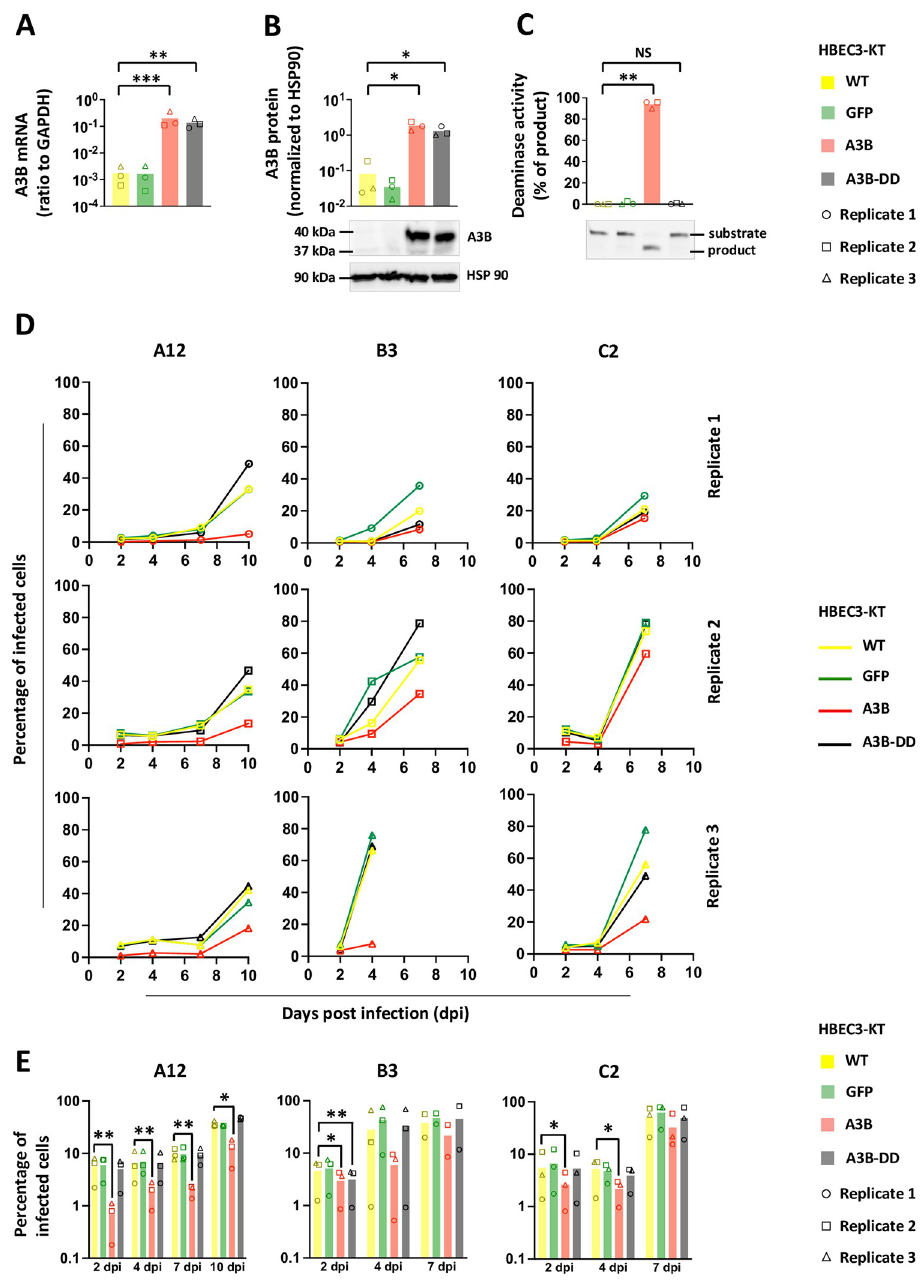
Fig 1. A3B slows down adenovirus propagation by a deaminase-dependent mechanism. Immortalized human bronchial epithelial cells HBEC3-KT were transduced to stably express the GFP, the APOBEC3B protein (A3B) or a catalytically inactive version of the APOBEC3B protein (A3B-DD for Deaminase Dead). (A) A3B mRNA levels were quantified by RTqPCR and expressed relative to GAPDH mRNA level. (B) A3B protein levels were assessed by western blot, quantified by densitometry and normalized with HSP90. (C) Total proteins were extracted in a non-denaturing buffer and mixed with the substrate of the deamination assay. Deaminase activity, if present in the cell lysate, will allow the conversion of substrates into shorter products. Substrates and products were quantified by densitometry. Deamination activities of the cell lysates were expressed as the percentage of substrate converted into product. P-values were calculated by t-tests. (D-E) HBEC-WT, -GFP, -A3B and -A3B-DD were infected with HAdV-A12, -B3 or -C2 at a MOI = 0.03. The percentage of infected cells were quantified by flow cytometry at different time points post infection. The results of the 3 biological replicates are shown separately (D) or pooled together (E). P-values were calculated by ratio t-tests. Only significant differences are shown.